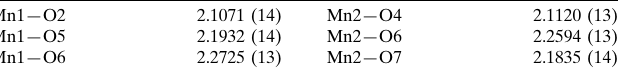
Selected geometric parameters (A˚ , (cid:3) ).